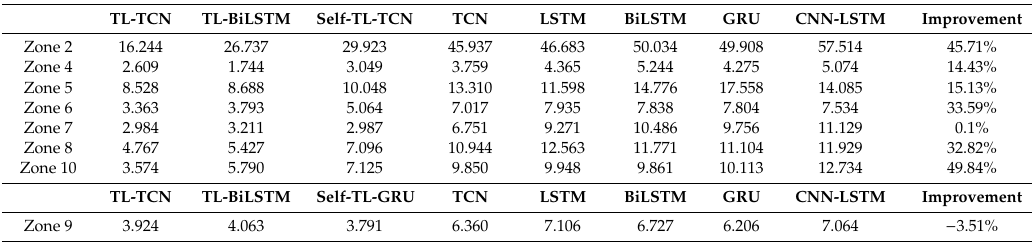
Table 14. RMSE score when zone 3 is the source